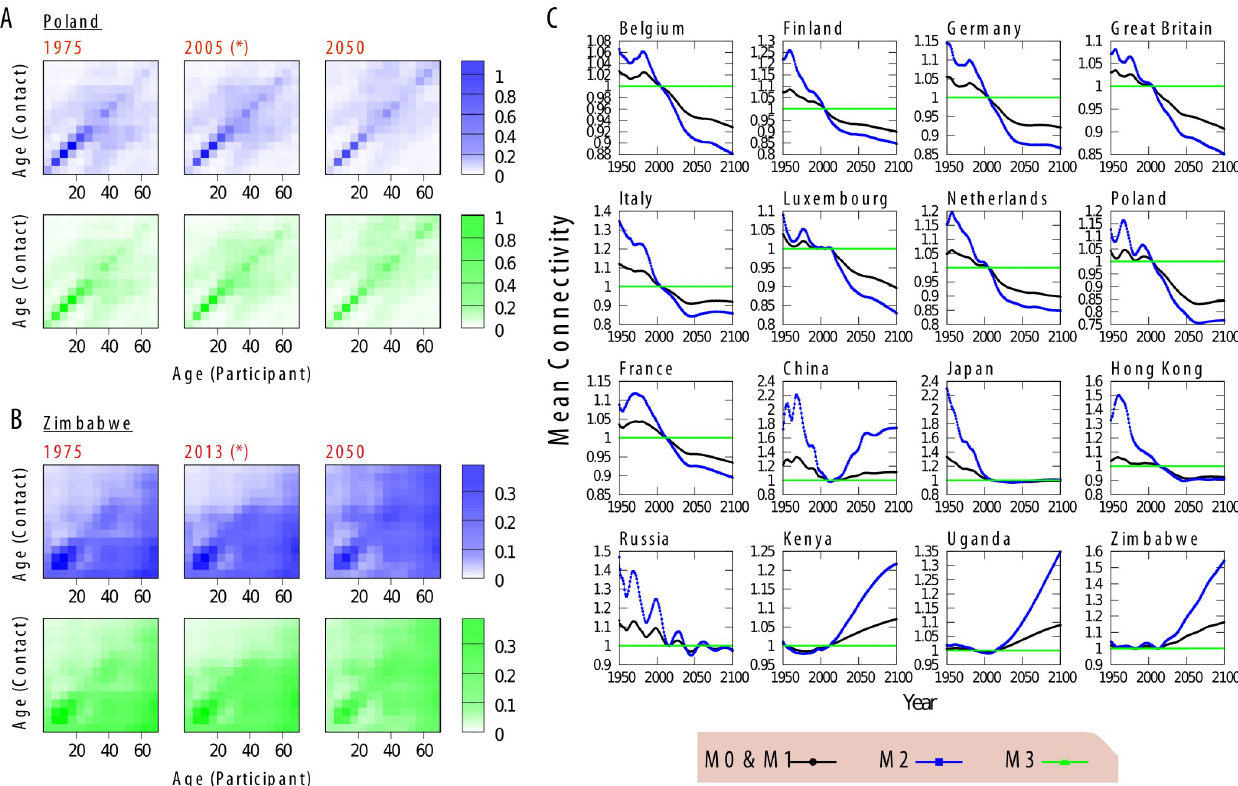
Fig 2. Analysis of methods M2 and M3. A-B: Contact patterns M Zimbabwe, respectively. C: Evolution of Mean Connectivity for M2 (blue), M3 (green) and M0 and M1 (black, both methods give the same mean